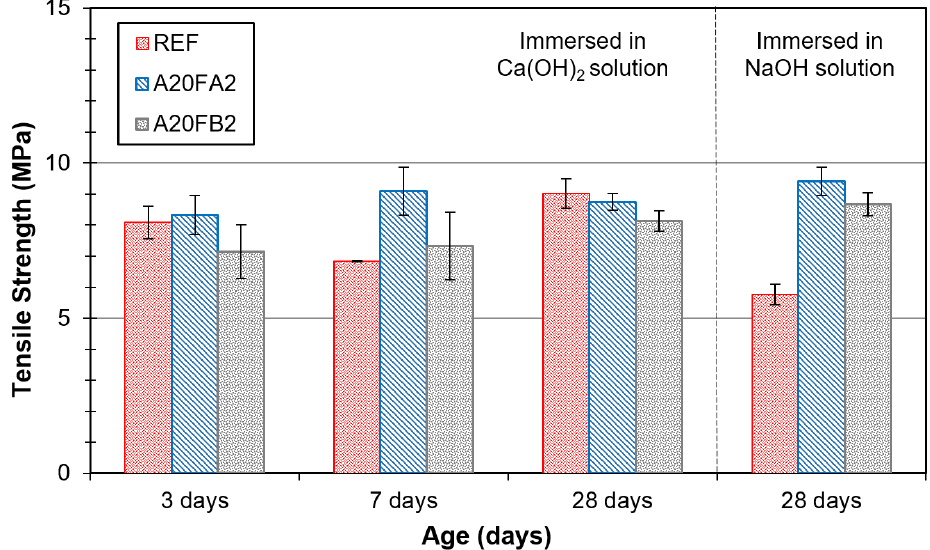
Figure 11. Tensile strength in the bending of reference mortars and containing 20% of the GRF, at 3, 7 and 28 days immersed in saturated solution of lime and at 28 days immersed in solution of NaOH